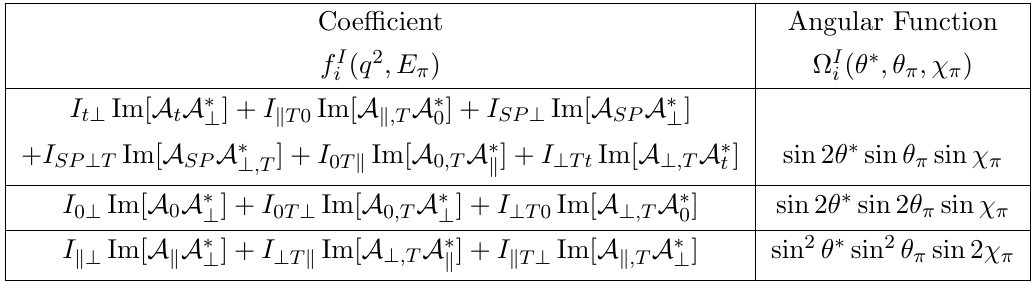
Im[ A i A (cid:3) ] [eq. (2.15)] to the angular distribution. These terms are i;j j